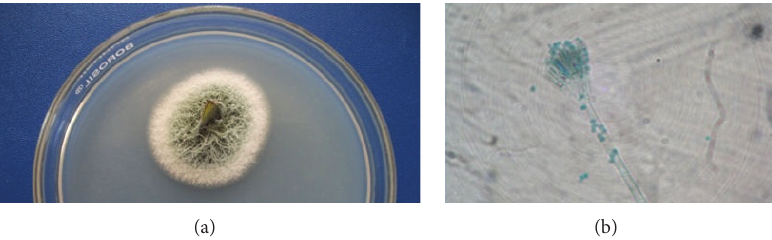
Figure 1: (a) Endophytic fungi grown from sterilized leaf segment of Curcuma longa on PDA. (b) Microscopic image of endophytic fungi, Penicillium sp.